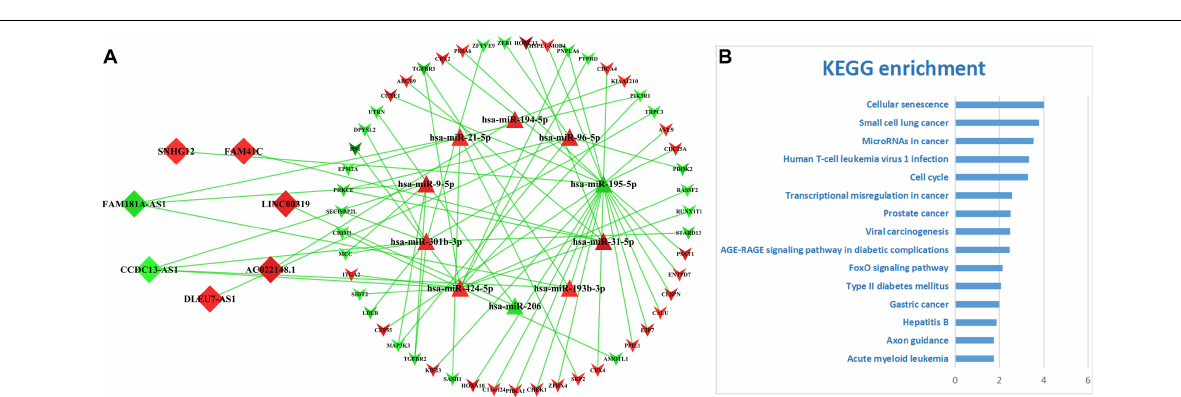
FIGURE 7 | The ceRNA subnetwork mediated by the lncRNA-based signature. (A) The ceRNA subnetwork depicting the relationships between seven lncRNAs and their counterparts. Diamonds represent lncRNAs, triangles miRNAs, and inverse-triangles mRNAs. The red color depicts upregulation and green downregulation. (B) The top 15 significantly enriched KEGG